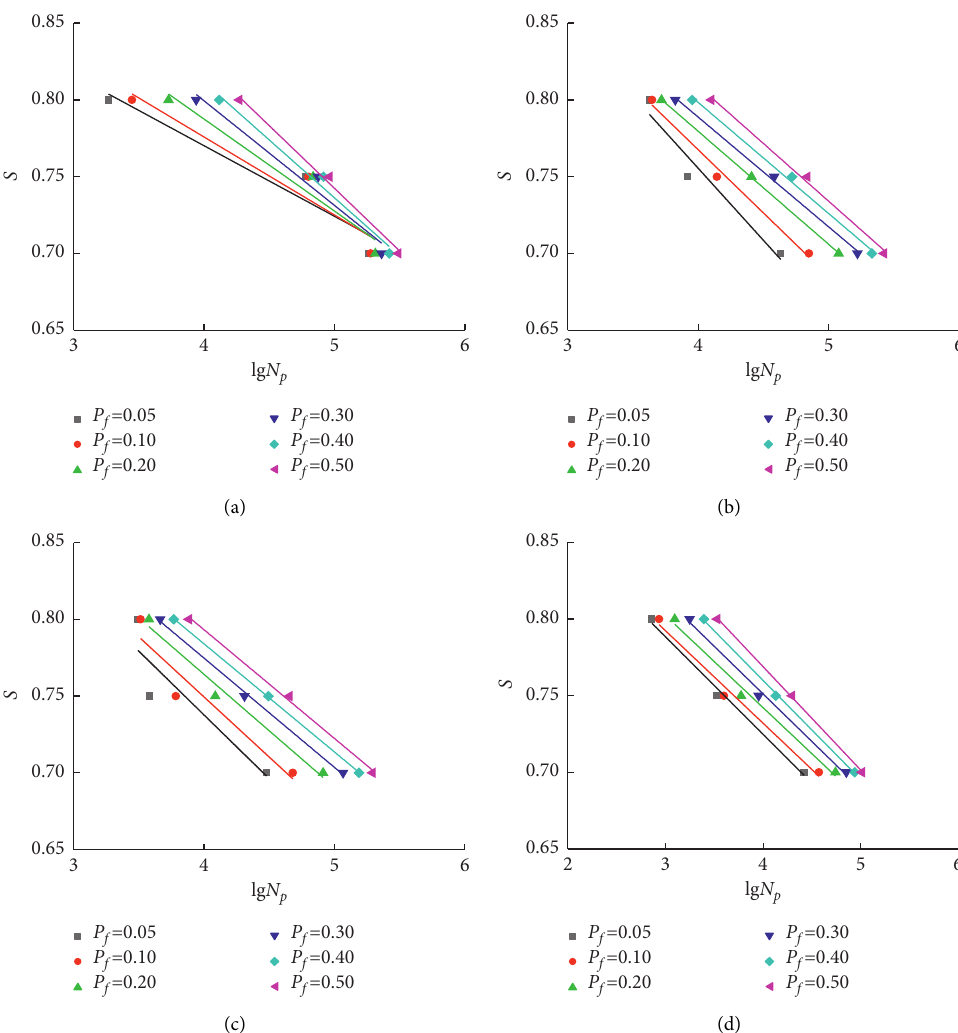
Figure 12: S –lgN relationships of AASC with various degrees of frost damage for various failure probabilities.(a) n � 0. (b) n � 50. (c) p n � 100. (d) n �